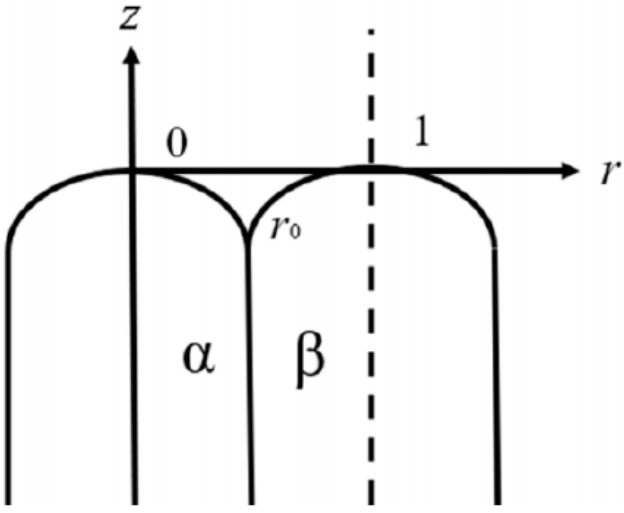
Figure 1. The geometry model of the metal–metal rod eutectic